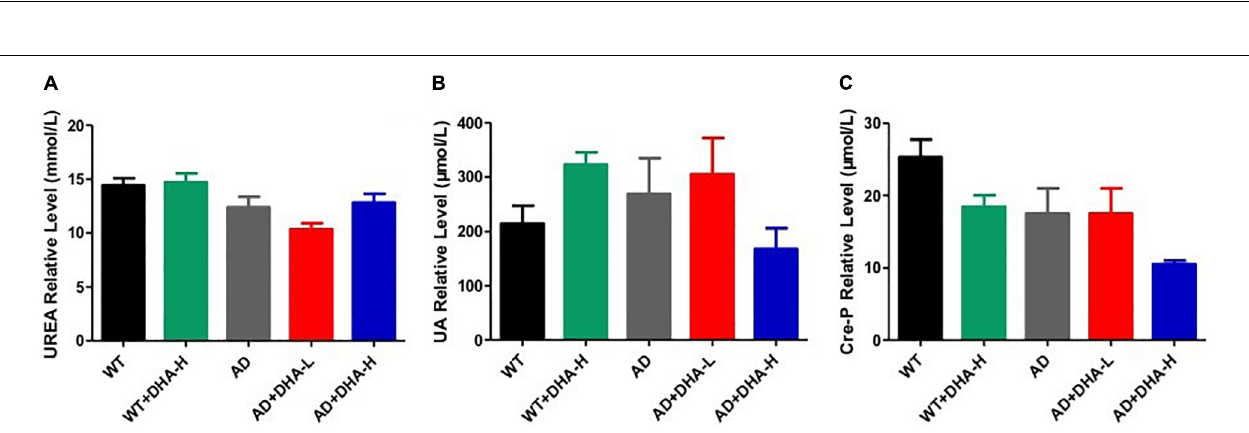
Frontiers in Nutrition |